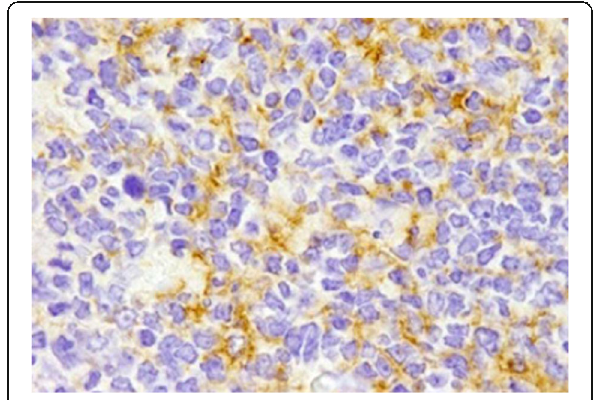
Fig. 6 Positive immunohistochemical staining for HIV-1 p24 antigen in follicular centres and dendritic cells (original magnification